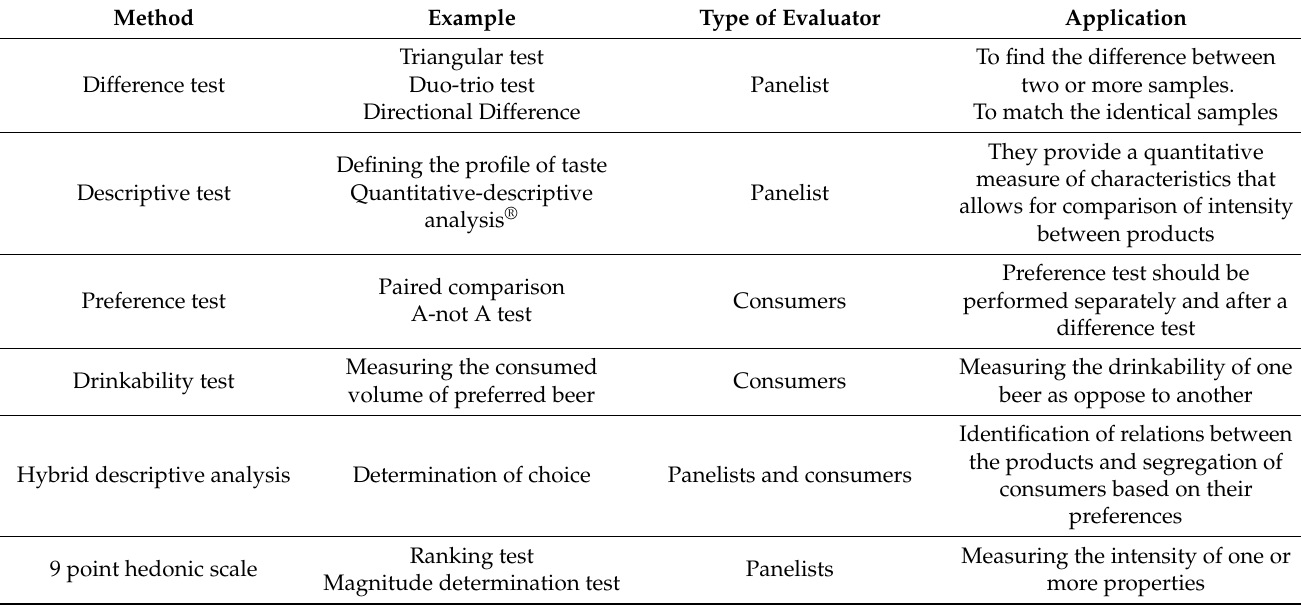
Table 2. Common sensory analysis used in breweries, adapted from